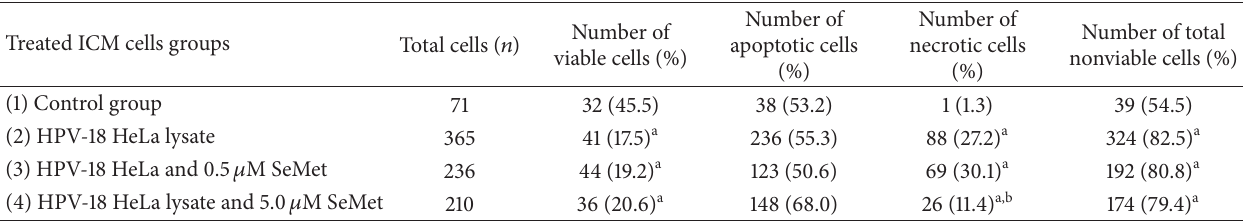
Table 3: Day 6 in vitro implanted mouse embryos were exposed (at 37 ∘ C, 5% CO heat-inactivated HPV-18 HeLa lysate, (2) HPV-18 HeLa lysate, (3) HPV-18 HeLa lysate and 0.5 𝜇 M selenomethionine (SeMet), or (4) HPV-18 HeLa lysate and 5.0 𝜇 M SeMet. The percentages of live, apoptotic, and necrotic inner cell mass (ICM) cells were assessed using bisbenzimide and propidium iodide dual-stain epifluorescence analyses.